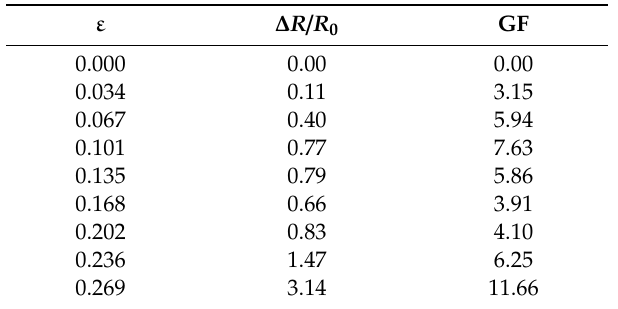
Table 2. Listed HRS data of ∆ R / R 0 versus ε for the GF calculation.